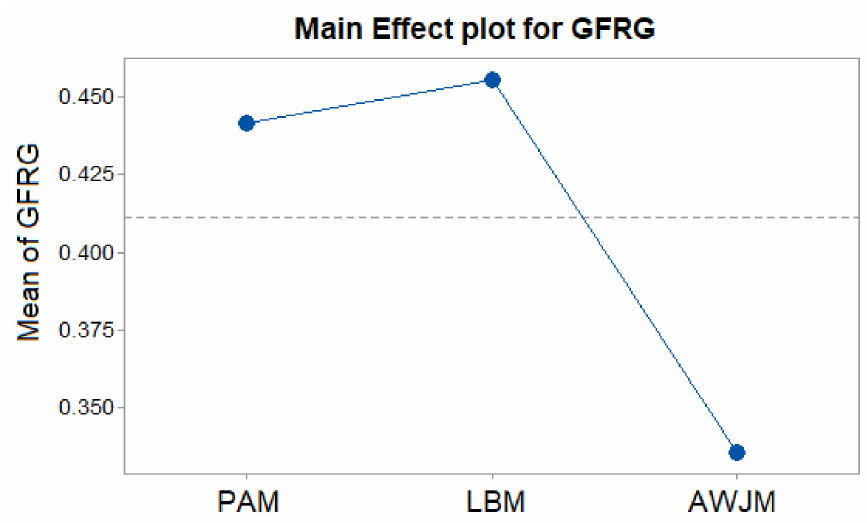
Figure 8. Main effect plot of